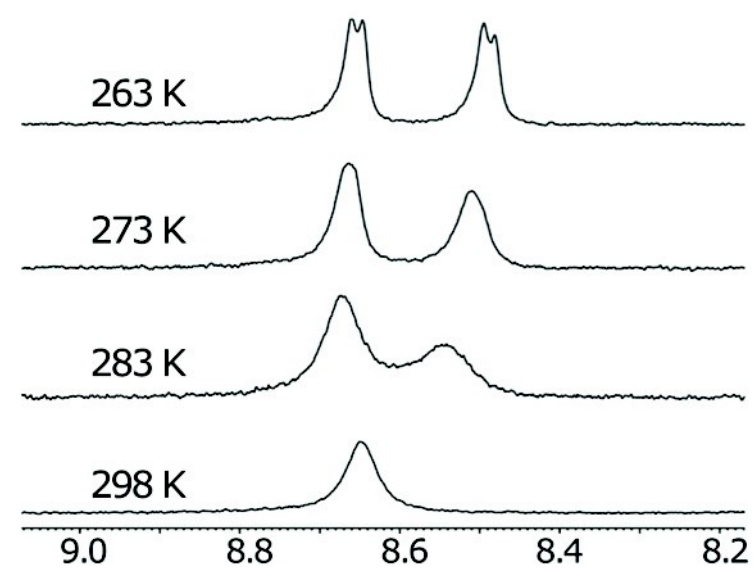
Figure 7. 1 H-NMR spectrum of the NDI protons of a solution of 4a in TCE, at different temperatures. Partially reproduced with permission from Ref. [46] (Copyright American Chemical Society, 2012).